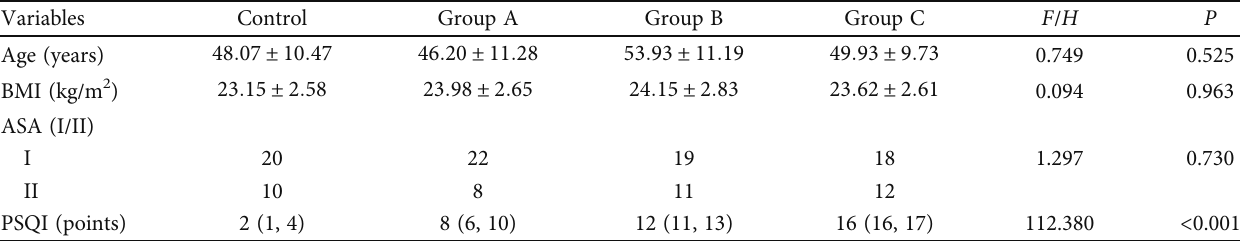
Table 1: Comparison of general data ( n = 30